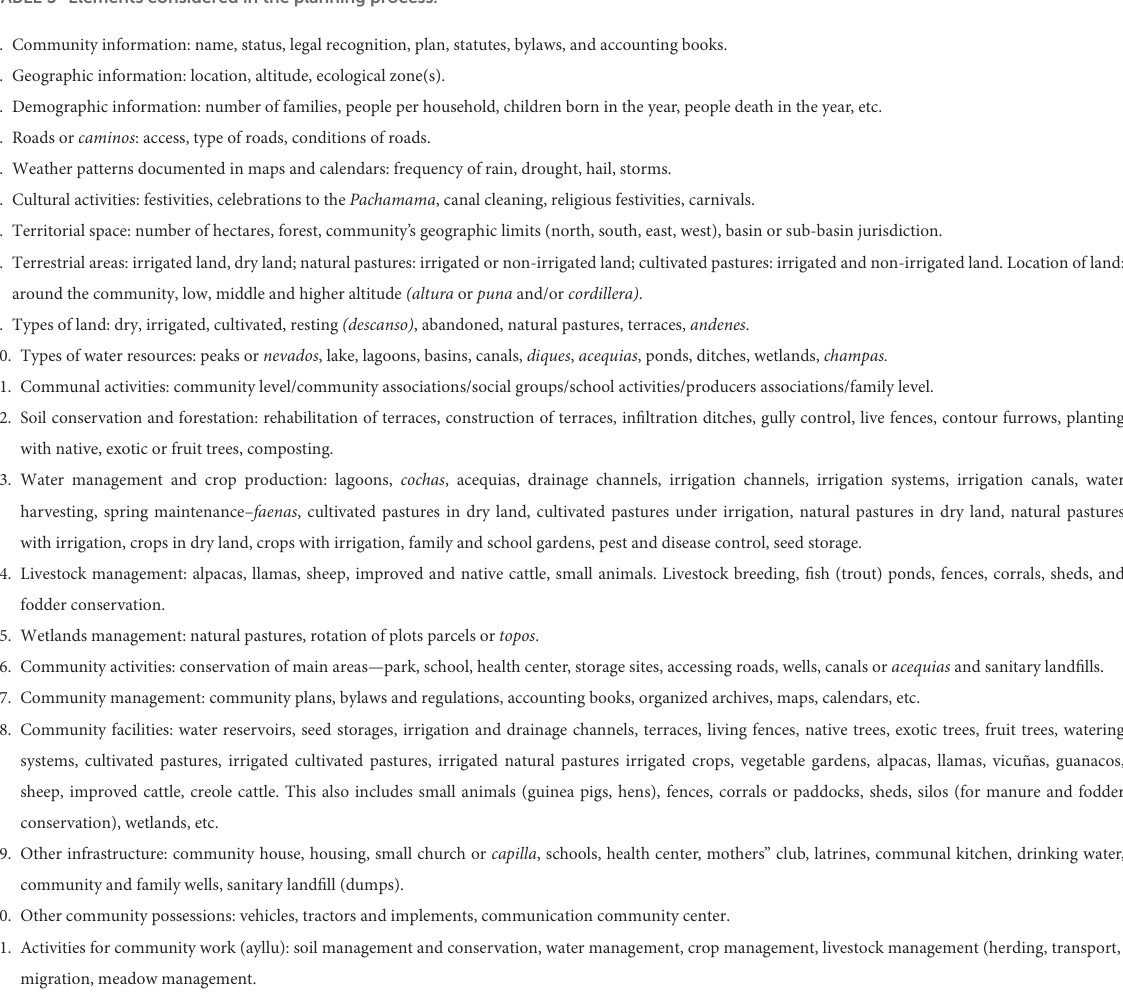
TABLE 3 Elements considered in the planning